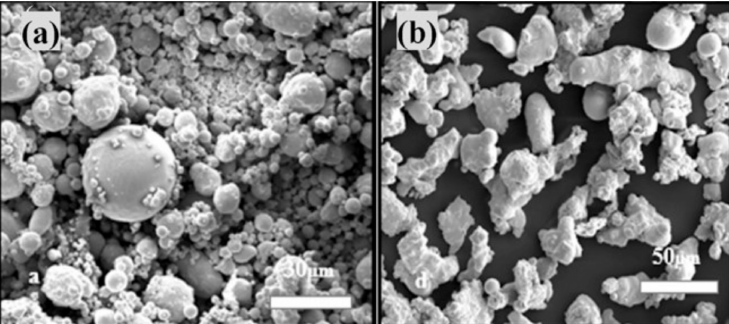
Figure 5. Micromorphology of 17–4 PH SS powder: ( a ) gas-atomized powder and ( b ) water-atomized powder [125]. (reproduced from [125], with permission from Elsevier, 2018). Table 1. The e ff ect of atomized media and building atmosphere on the amount of retained austenite. Powder